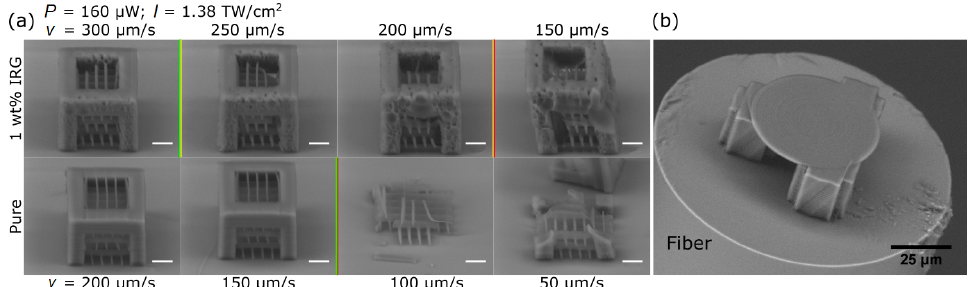
Figure 2. ( a ) reduction of structural quality in the case of photosensitized and pure SZ2080. Photoinitiator Irgacure 369 (IRG) containing cubes degrade slower and in a more progressive fashion. Conversely, the structures out of non-photosensitized material completely break up as soon as the fabrication parameters are not in the ∆ I . All scales are 5 µ m; and ( b ) monolithic micro-optical element on the tip of an optical fiber fabricated out of non-photosensitized